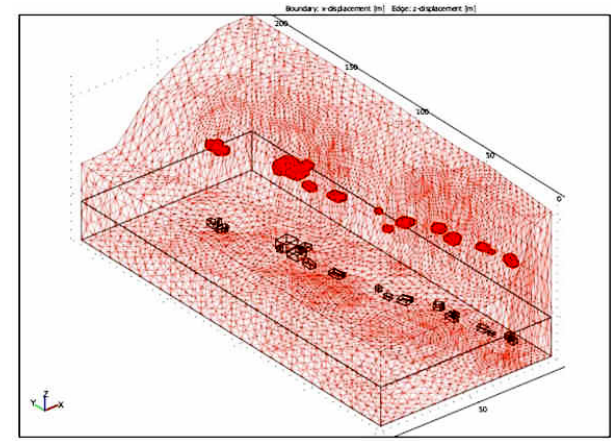
Fig. 12. Section 2. Geological technical model. It has been de- fined according both to geological field survey and to the results of all carried investigations. This conceptual model represents the stratigraphical conditions and the pore pressure regime, and takes into account the physical and mechanical characterisation of soils to define a numerical model capable of predictive analysis.